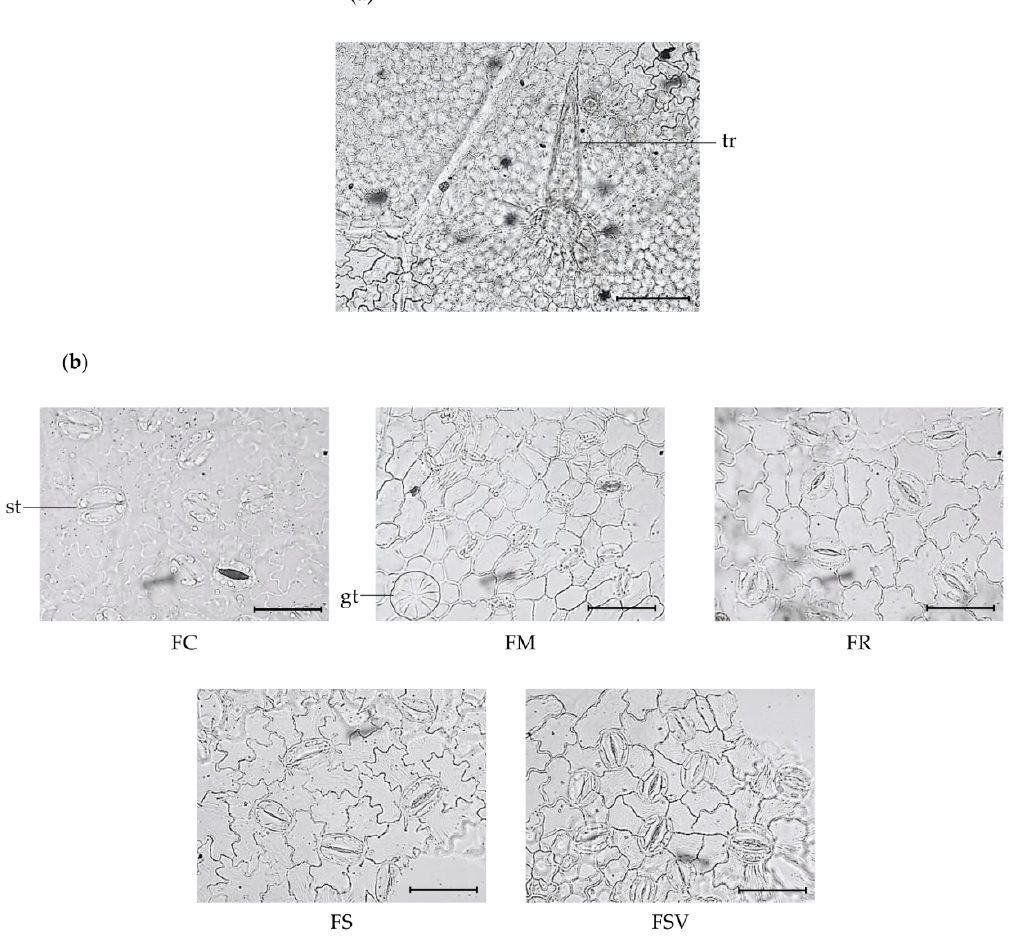
Figure 1. Photomicroscopic data of the leaf surface of five Fraxinus plants: ( a ) epidermal cells are arranged in a rosette around trichome base on the lower surface ( F. rhynchophylla ) ( × 400). The black bar means 100 µ m; ( b ) photomicroscopic data of the lower surface of leaves from five plants ( × 1000). Black bars mean 50 µ m; gt , glandular trichome; st , stomata; tr , trichome; FC, Fraxinus chiisanensis ; FM, F. mandshurica ; FR, F. rhynchophylla ; FS, F. sieboldiana ; FSV, F. sieboldiana var. angustata .